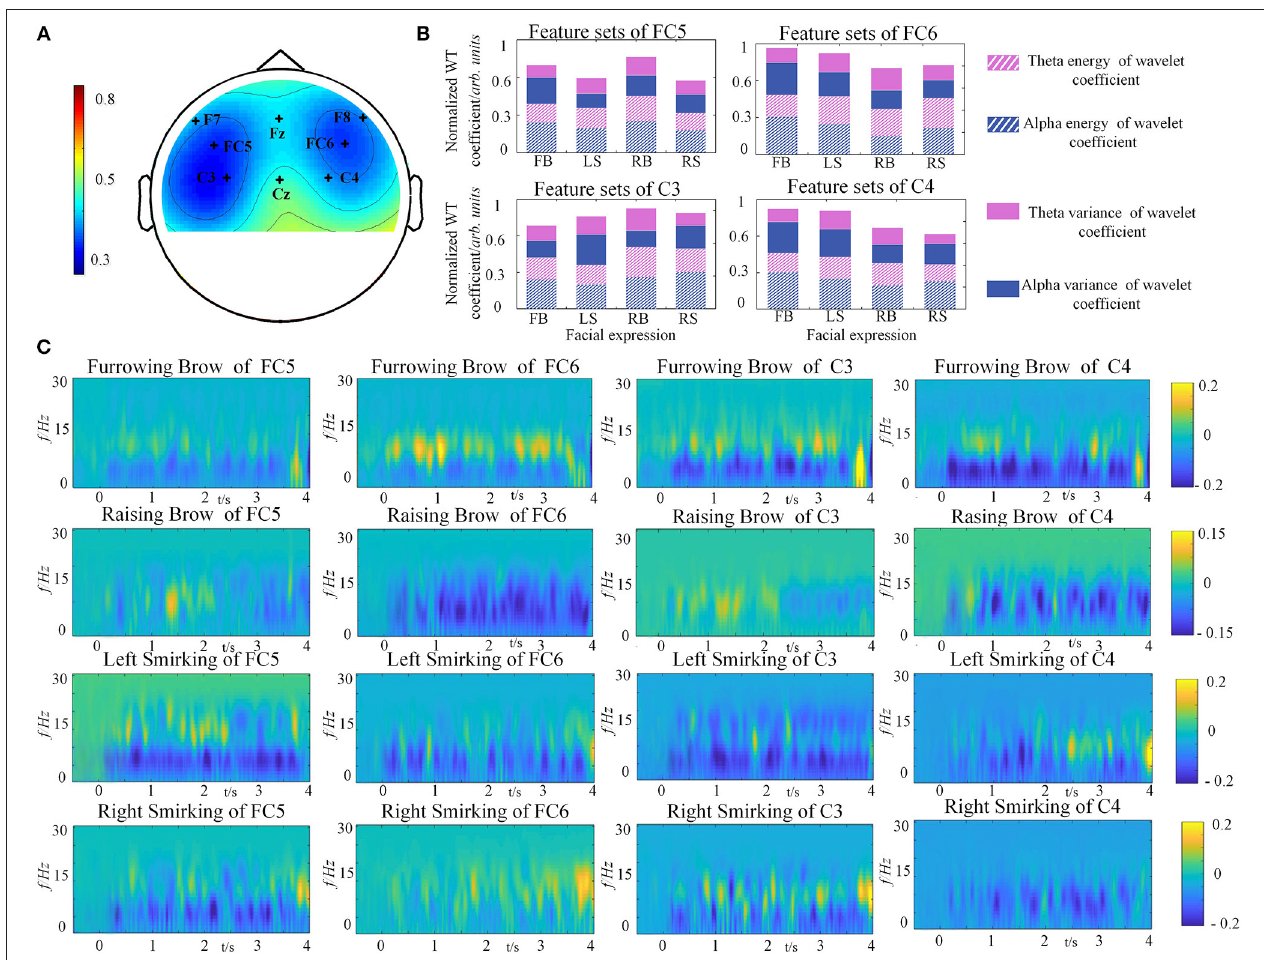
FIGURE 5 | Grand average results from one representative subject (S5). (A) Topographic map of the correlation coefficients of four facial expressions’ relations. The degree of correlation differences is depicted by the colored scale. (B) The feature sets of four facial expressions from C3, C4, FC5, and FC6. (C) The power distributions of the average four facial expression from FC5, FC6, C3, and